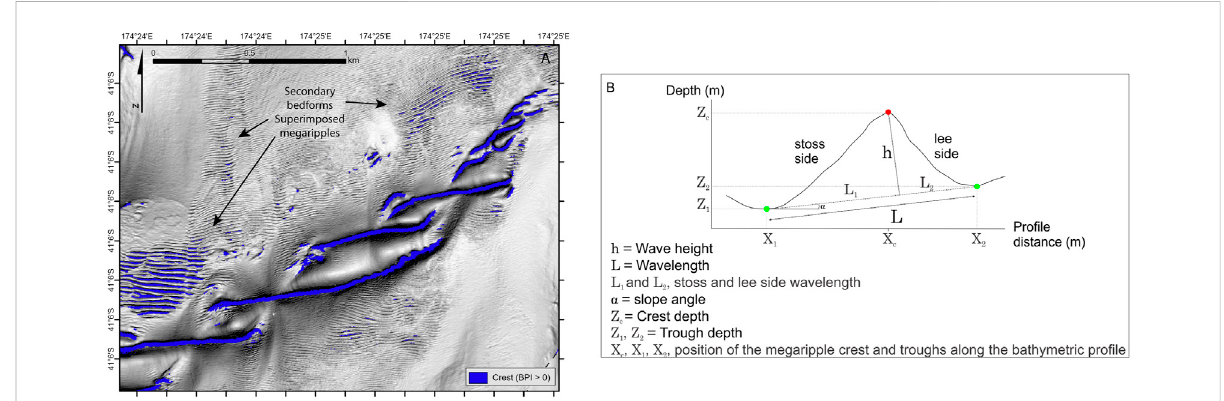
FIGURE 2 (A) Bathymetric position index (BPI) overlain over greyscale slope map, detecting the gravel dune crests in blue (BPI > 0). (B) Schematic representation of the measurements extracted for each megaripple, used to calculate key geometric